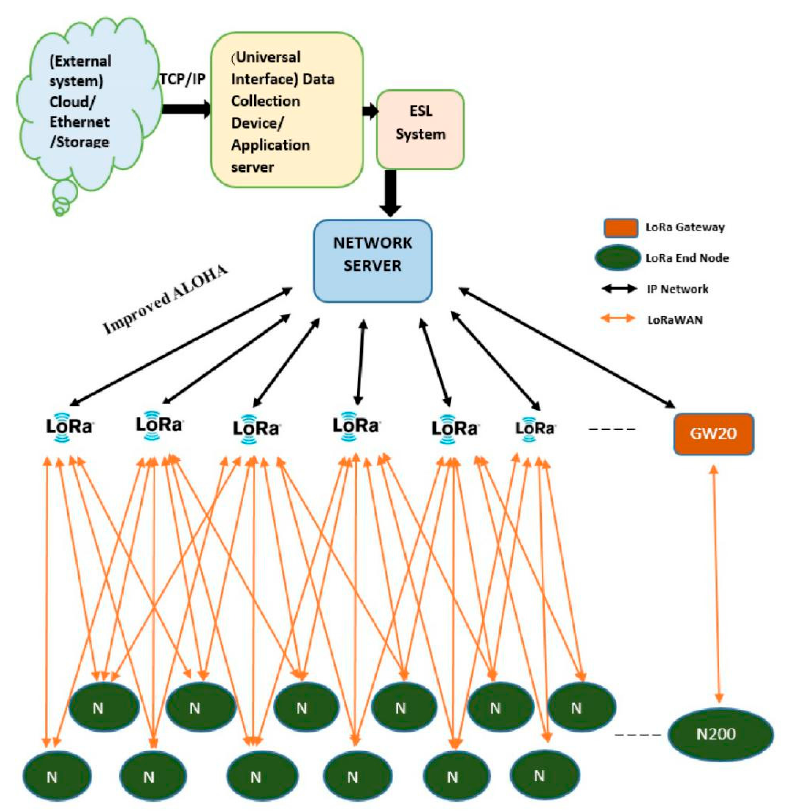
Figure 1. Overview of LoRa-based ESL.